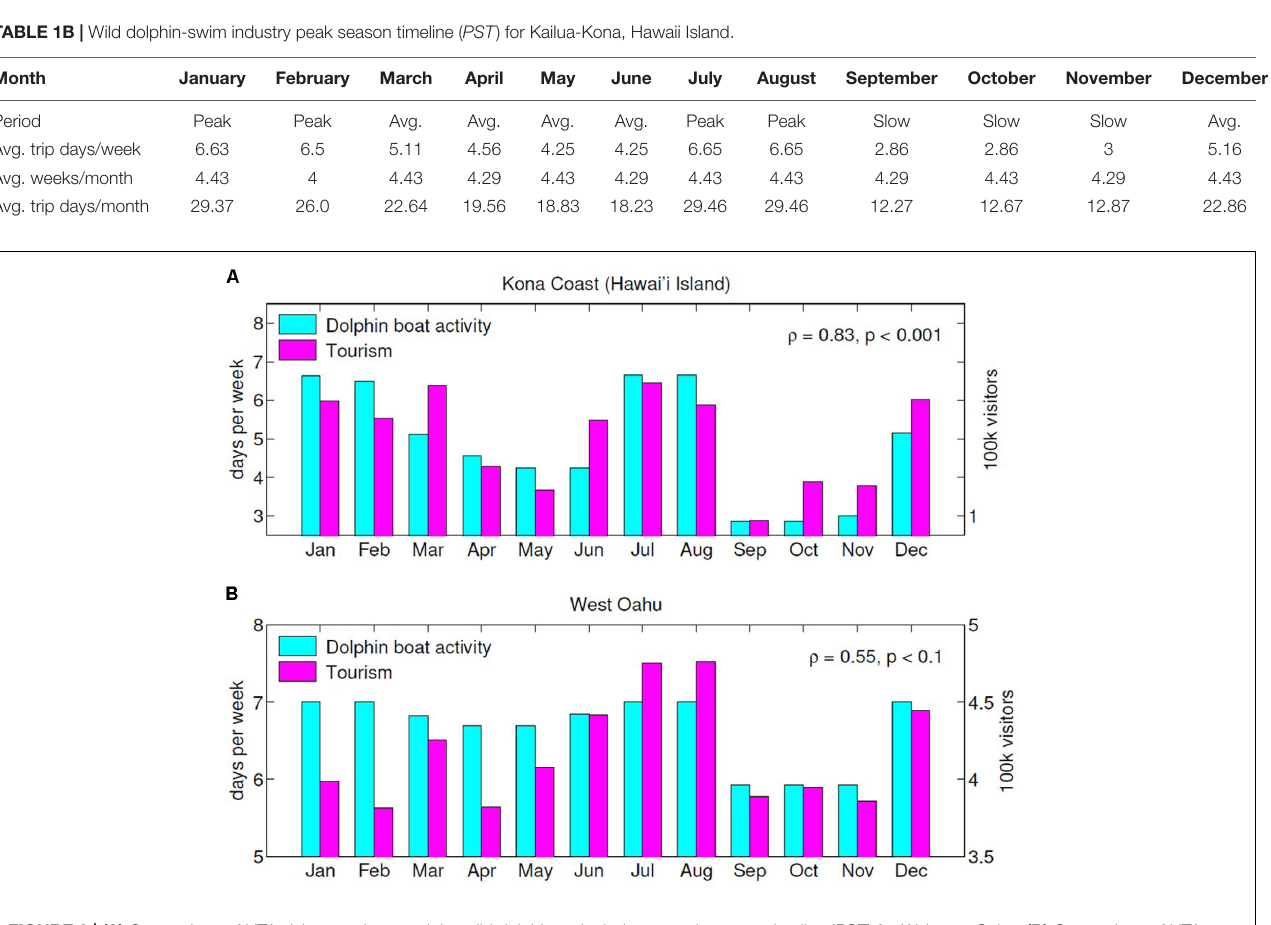
FIGURE 3 | (A) Comparison of HTA visitor numbers and the wild dolphin-swim industry peak season timeline ( PST ) for Waianae, Oahu. (B) Comparison of HTA visitor numbers and the wild dolphin-swim industry peak season timeline ( PST ) for Kailua-Kona, Hawaii